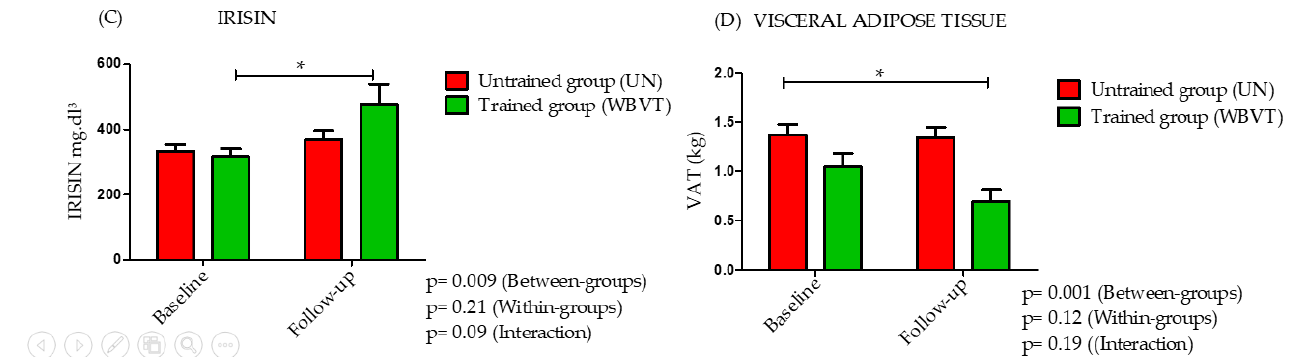
Figure 4. Effects of 6 weeks of whole-body vibration training (WBVT) stimulus on blood oxidative stress biomarkers and irisin levels. Plasma levels of thiobarbituric acid (TBARS) ( A ), catalase (CAT) ( B ), irisin ( C ), and visceral adipose tissue (VAT) ( D ) in control group (UN; n = 20) and training group (WBVT; n = 20). Values are presented as means and standard deviation. * Difference between groups ( p < 0.05).